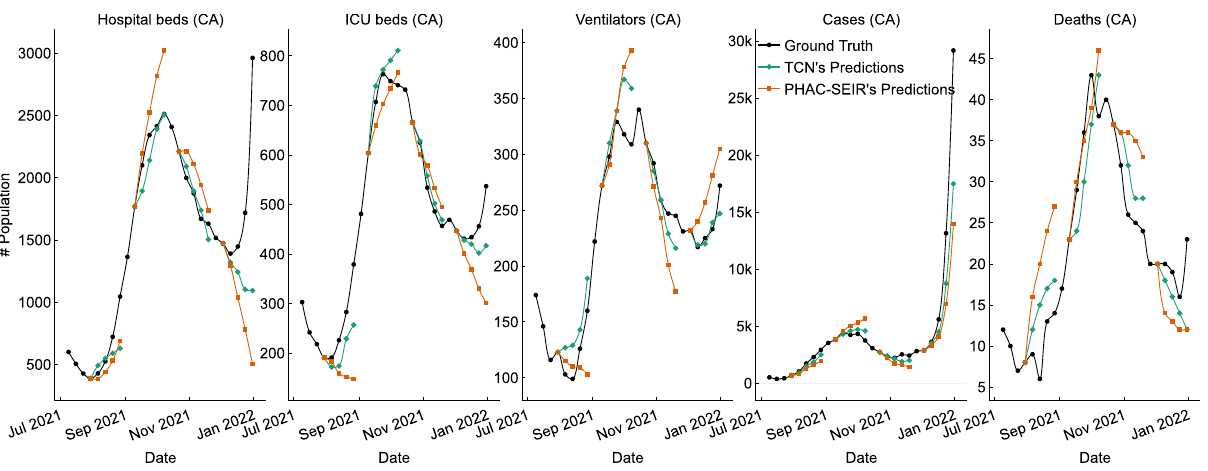
Figure 9. Forecasts made by TCN and PHAC-SEIR on 30 July, 10 Sept, 22 Oct, and 3 Dec 2021 in Canada